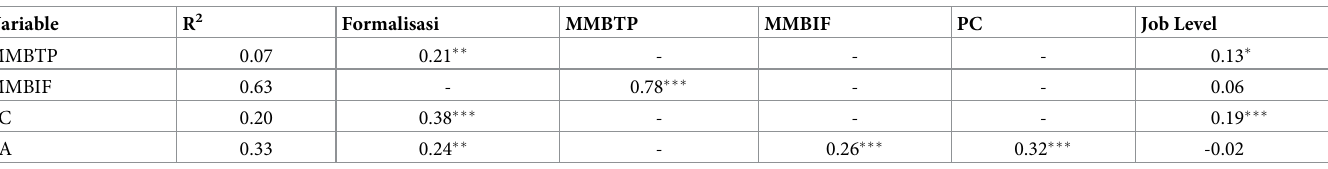
32% of employee accountability is influence by MMBTP, MMBIF, and perceived competence by controlling the job level. The results of hypothesis testing and the overall model are shown in Table 5 and Fig 2. In this research model, the job level has been controlled. Formalization has a significant positive relationship with employee accountability ( β = 0.24, p < 0.01). This positive relationship sup- ports hypothesis 1, which states that formalization is significantly and positively related to employee accountability. All indirect effects were tested using 5,000 bootstrap samples with a bootstrap confidence interval of 95%. The results of the analysis support the mediating effects of MMBTP and MMBIF ( β = 0.01, p < 0.01, CI[0.01, 0.03]), indicating that hypothesis 2 is sup- ported. The results of the analysis also support hypothesis 3, which assumes a mediating effect of perceived competence on the relationship between formalization and employee account- ability ( β = 0.04, p < 0.001, CI[0.02, 0.07]). The results of the analysis support all the hypothe- ses proposed in this study. In comparison, the direct effect of formalization and employee accountability is greater than the indirect effect mediated by both managerial monitoring behavior (task performance and interpersonal facilitation) and perceived competence. In the indirect effect between formalization and employee accountability, perceived competence shows a greater mediating effect than the mediating effect of managerial monitoring behavior. Table 5. Squared multiple correlation and standardized total